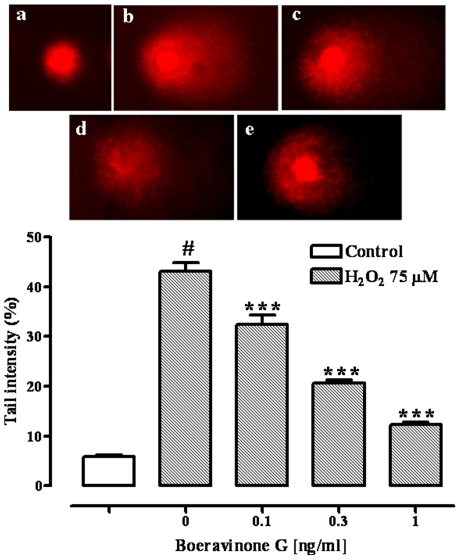
Effect of boeravinone G (BG, 0.1–1 ng/ml) on DNA damage.DNA damage (tail intensity) was detected by the Comet assay in Caco-2 cells exposed to 75 µM H2O2 for 5 min in absence or presence of boeravinone G. a = control; b = H2O2 75 µM; c = H2O2 75 µM+BG 0.1 ng/ml; d = H2O2 75 µM+BG 0.3 ng/ml; e = H2O2 75 µM+BG 1 ng/ml. Data represent mean ± SEM of 4 experiments. #p<0.001 vs control (vehicle) and ***p<0.001 vs H2O2 alone.